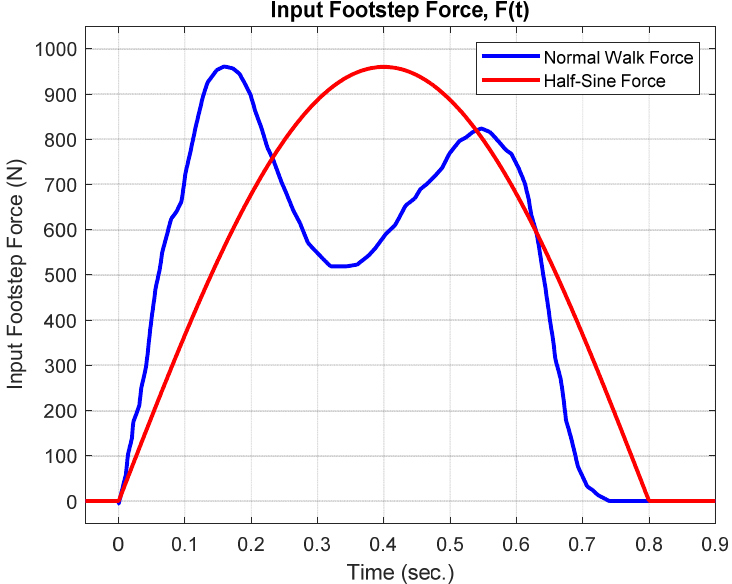
Figure 3. Input footstep force.